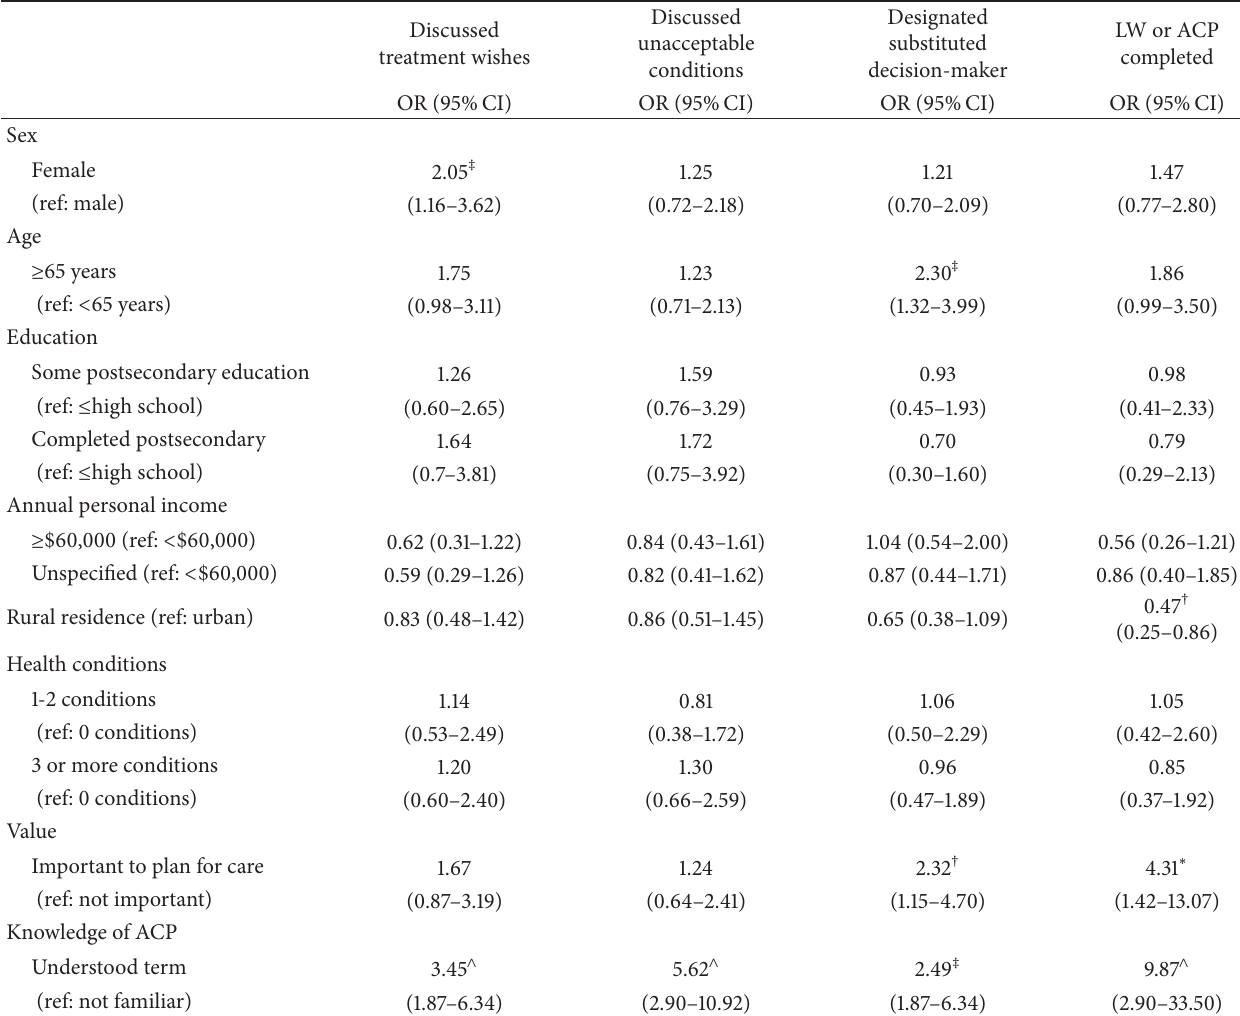
Table 3: Adjusted 1 associations between respondent characteristics and serious illness planning